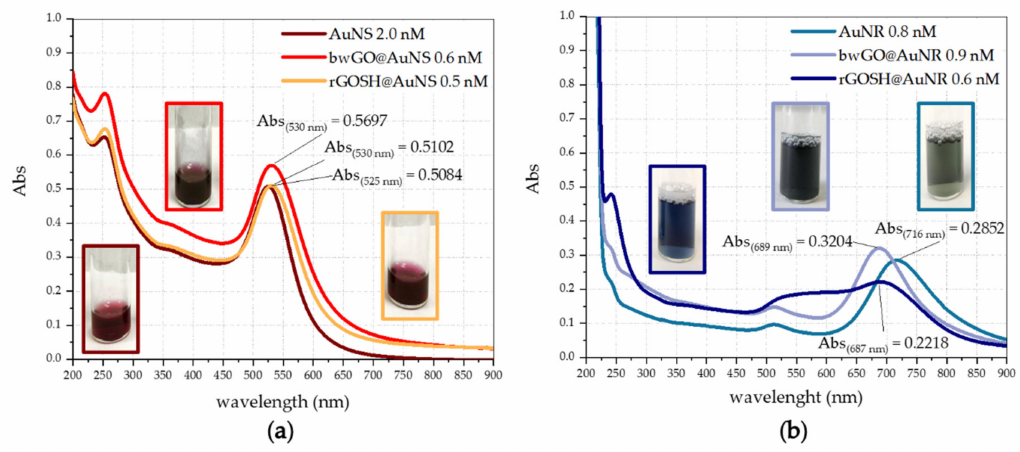
Figure 4. UV-VIS spectra for as-prepared samples of: ( a ) citrate-capped gold nanospheres (AuNS, wine line) and hybrids with base-washed GO (bwGO@AuNS, red line) or thiolated reduced GO (rGOSH@AuNS, orange line); ( b ) cetyl trimethylammonium bromide-capped gold nanorods (AuNR, cyan line) and bwGO@AuNR (light blue line) or rGOSH@AuNR (navy line)